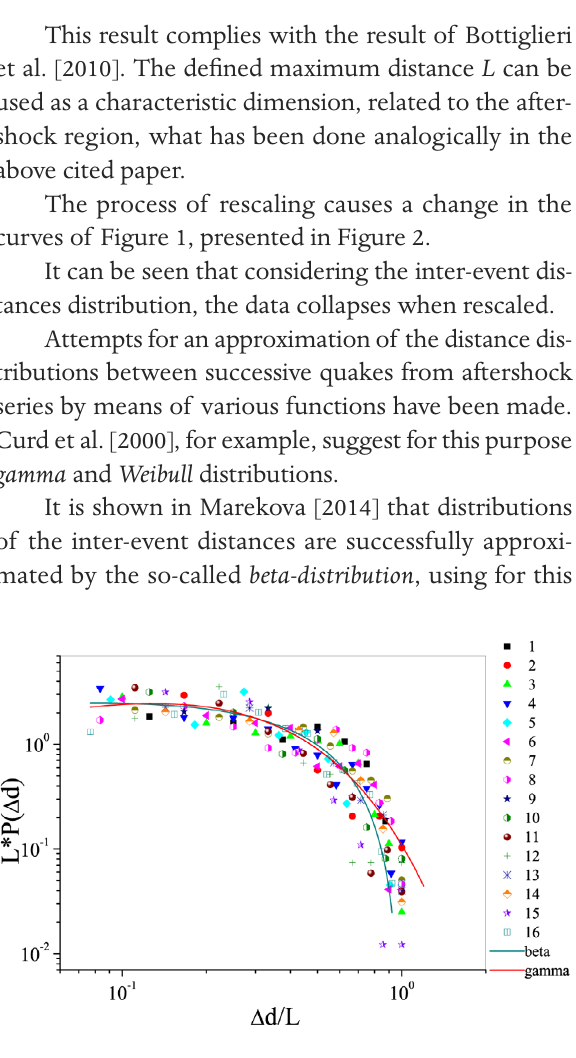
Figure 2. Probability density for the rescaled data: x = Δ d / L ; y = L * P ( Δ d ) from catalogs, listed in Table 1. The green continuous line is a beta distribution fit and the red continuous line - a gamma dis- tribution